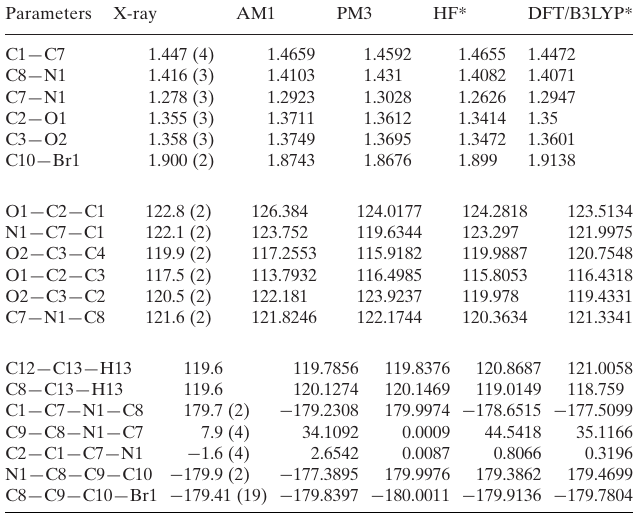
Selected geometric parameters (A˚ , (cid:2) ) from the X-ray structure and calculated by AM1, PM3, HF and DFT methods. Parameters